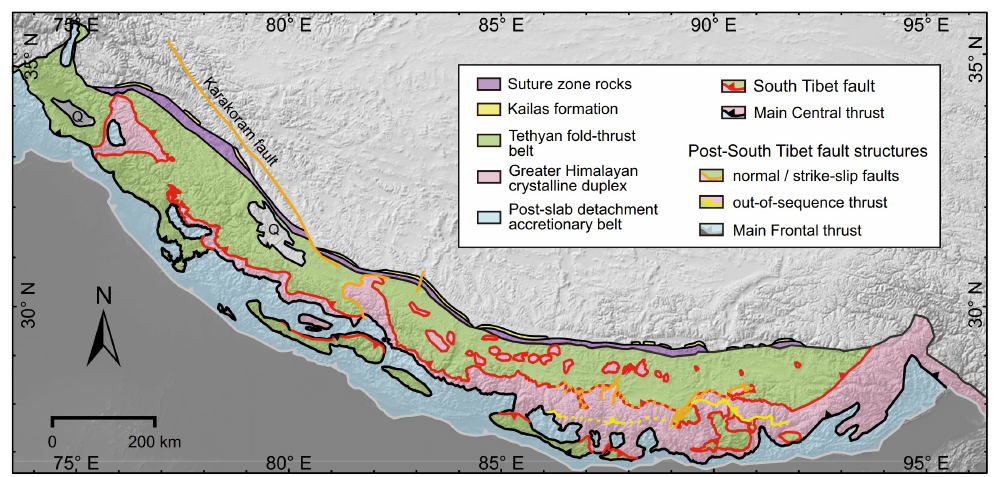
Figure 2. Geological map of the Himalayas (Source: Webb et al. [28]).